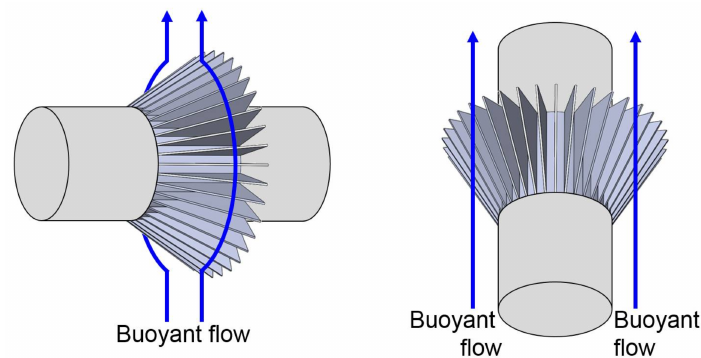
Figure 16. Finned cylinders when only two sides of cylinder bases are insulated.